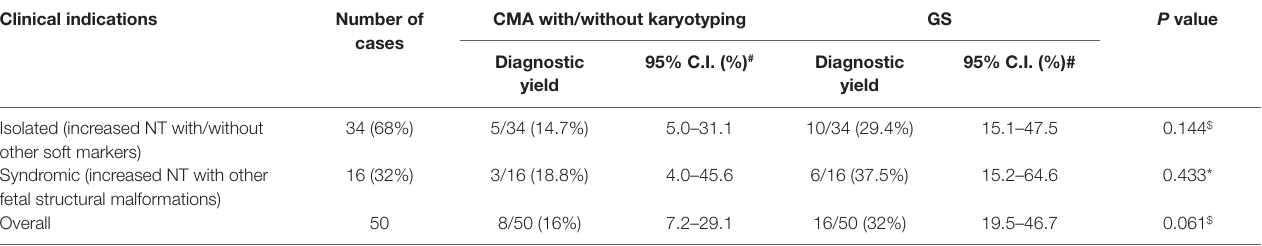
TABLE 1 | Prenatal detection rates of the fetuses with increased NT by CMA/Karyotyping and GS. Clinical